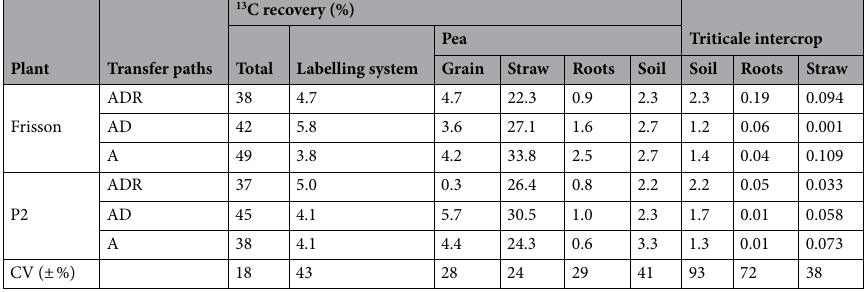
Table 2. Total 13 C recovery in the labelling systems and in pea plant parts supplied with the labelling solutions as well as in triticale plant parts as intercrop.